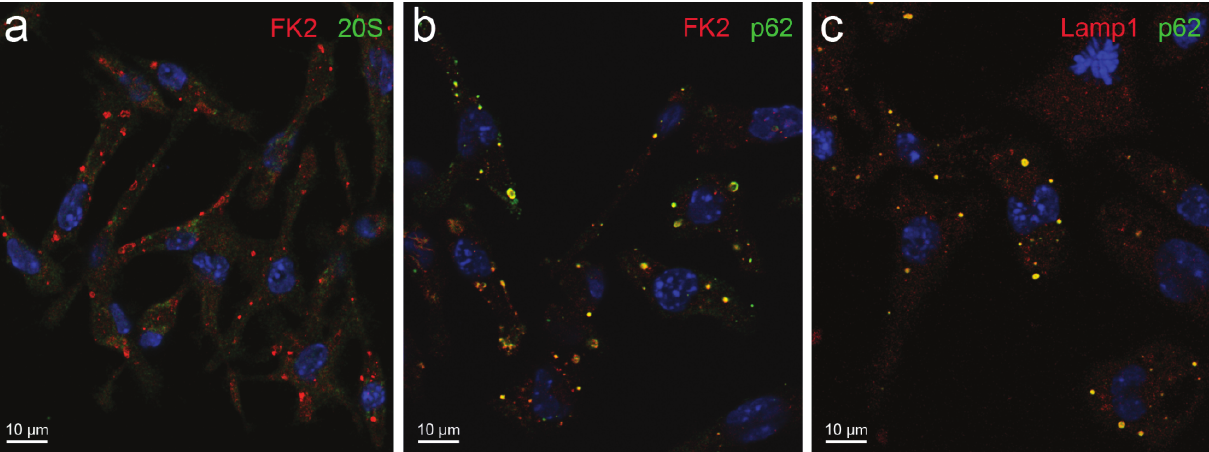
Figure 2. Cytoplasmic bodies in LPS-treated RAW 264.7 macrophage observed by confocal microscopy. Cells briefly fixed in formaldehyde and permeabilized with saponin show ( a ) immunofluorescent cytoplasmic bodies intensely reactive for ubiquitin (FK2 antibody specific for both mono- and poly-ubiquitinated proteins [19]) and unreactive for the 20S proteasome. Colocalizations (yellow) between FK2 and p62 protein, as well as between the late endosome/lysosome marker, LAMP1 and p62 are shown ( b , c ). Blue,